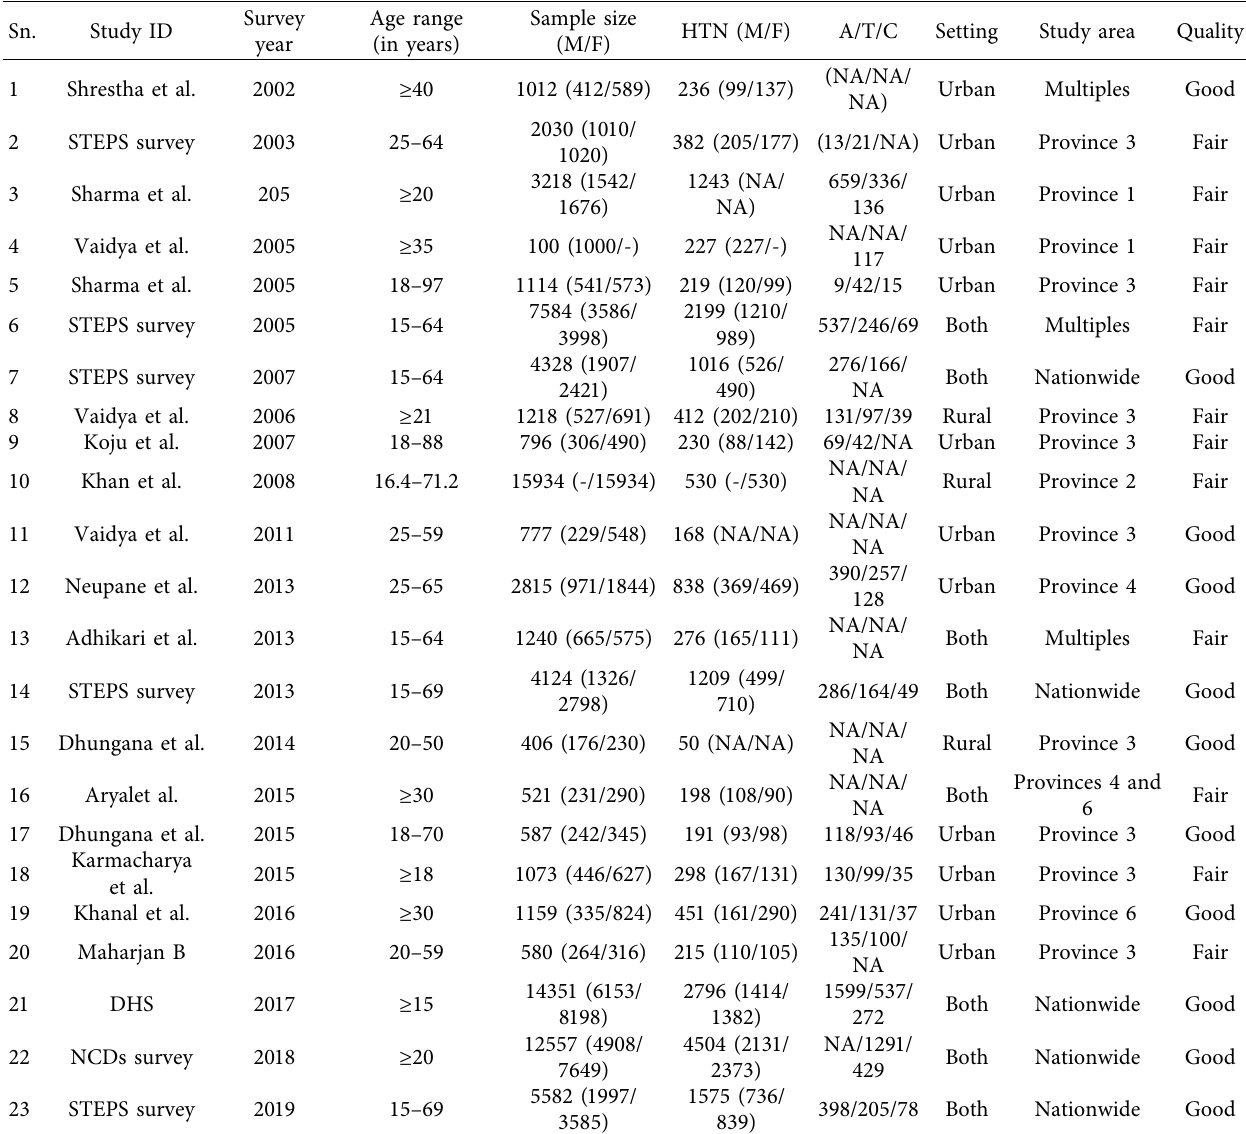
Table 1: Study characteristics.